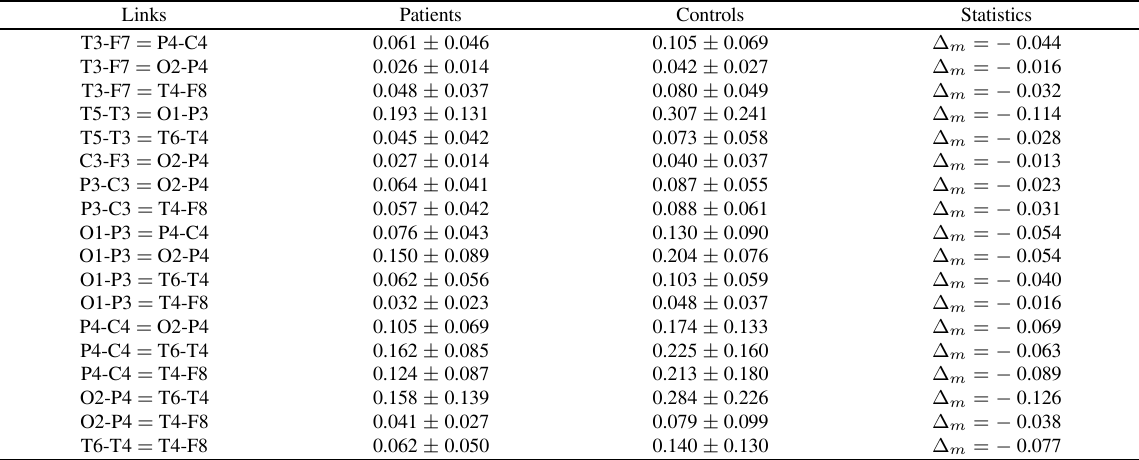
Table 3 Statistical results for the links where both size and weight statistical criteria are signi fi cantly different between patients and controls. Mean mutal information ( ± standard deviation) is given for both groups together with the results of the Δ m statistics of the permutation test. In all cases the p-values are lower than 10 − 4 Links Patients Controls